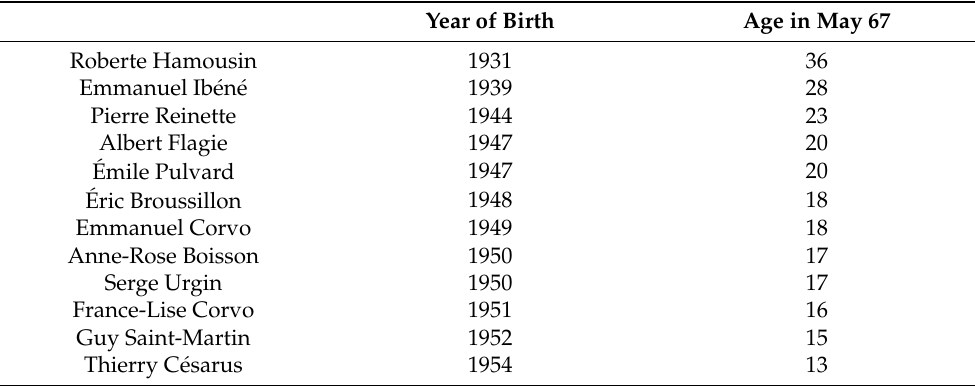
Table 1. Actors selected for the